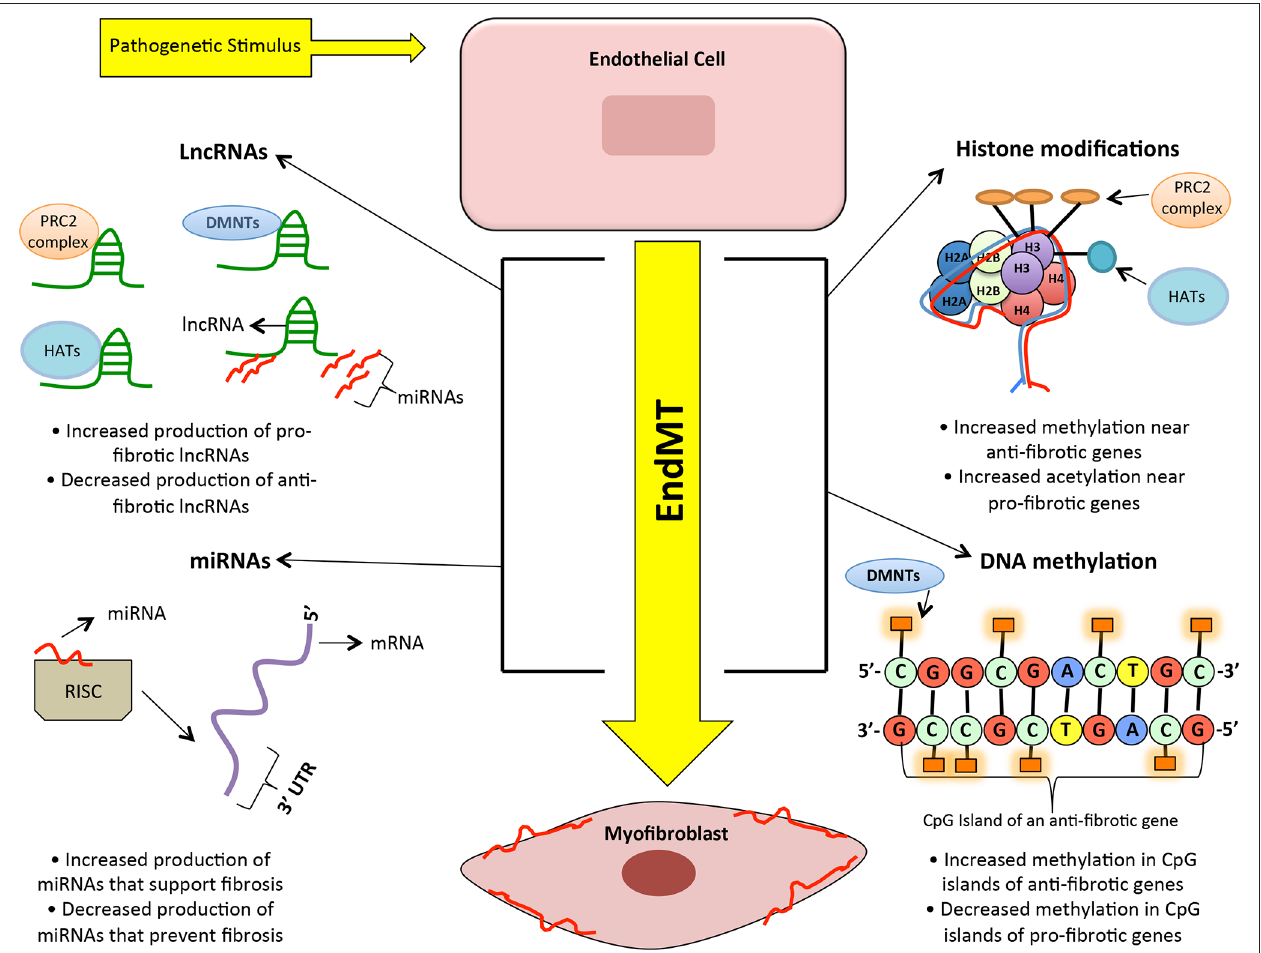
FiGuRe 3 | A simplified visual representing the interplay of many epigenetic processes that enhance endothelial-to-mesenchymal transition in diabetic cardiomyopathy. Legend: PRC2 complex = Polycomb repressive complex 2, HDAC = Histone acetyltransferases, DMNTs = DNA methyltransferases, LncRNA = Long non-coding RNAs, miRNA = microRNA, 3’ UTR = three prime untranslated region, mRNA = messenger RNA, and EndMT = endothelial to-mesenchymal